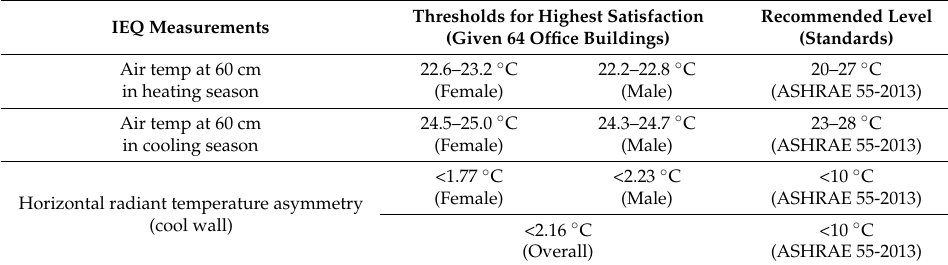
Table 18. Redefined thresholds for user thermal satisfaction derived from 64 office